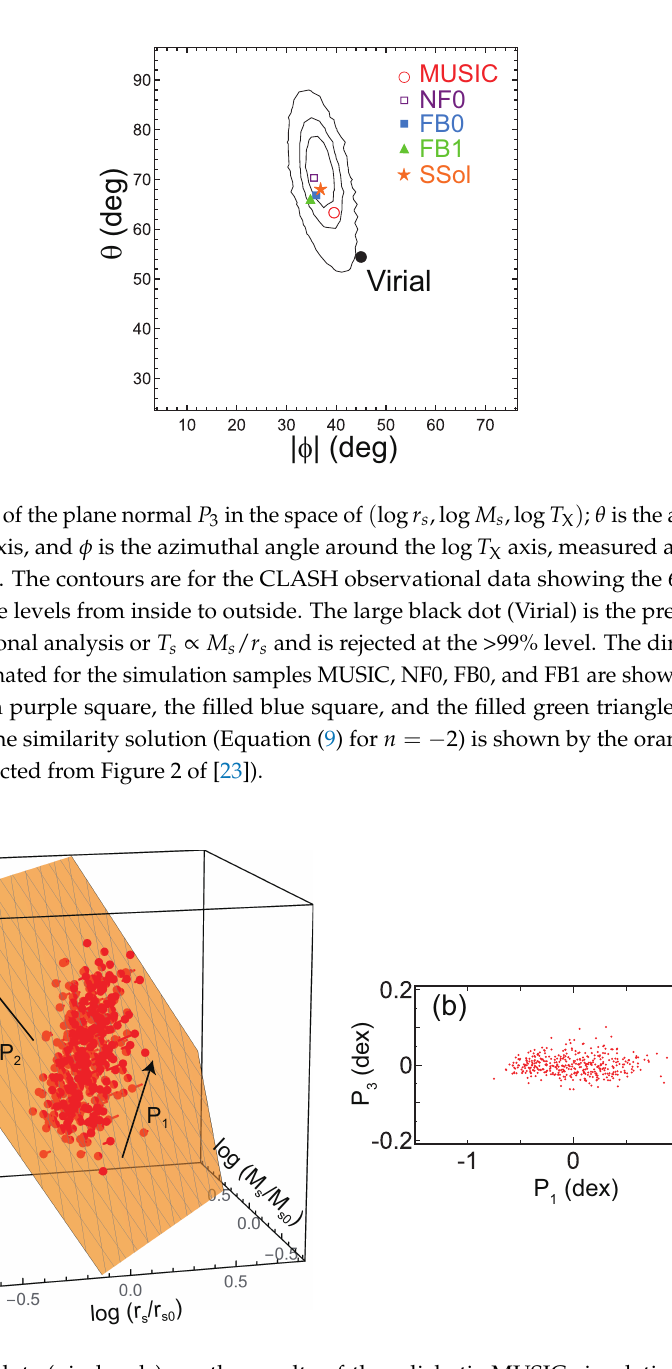
Figure 3. ( a ) Red dots (pin heads) are the results of the adiabatic MUSIC simulations ( z = 0.25). The axes are normalized by the average parameters of the sample ( r s 0 = 414 kpc, M s 0 = 1.4 × 10 14 M (cid:12) , and T X 0 = 3.7 keV). The orange plane is the best fit of the data. The arrow P 1 shows the direction to which the data distribution is most extended, and the arrow P 2 is perpendicular to P 1 on the plane. ( b ) The cross-section of the plane in ( a ). The direction P 3 is the plane normal (Figure is reconstructed from Figure 3 of